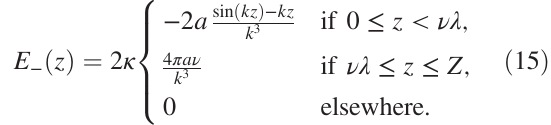
FIG. 1. Example of current profiles described by Eq. (6) (shaded line) with the corresponding induced voltages. The total bunch length is set to Z ¼ 5 λ (i.e., N ¼ 5 ) and plots (a) and (b), respectively, correspond to the cases q ¼ 2 and q ¼ 3 . The head of the bunch is at kz ¼ 0